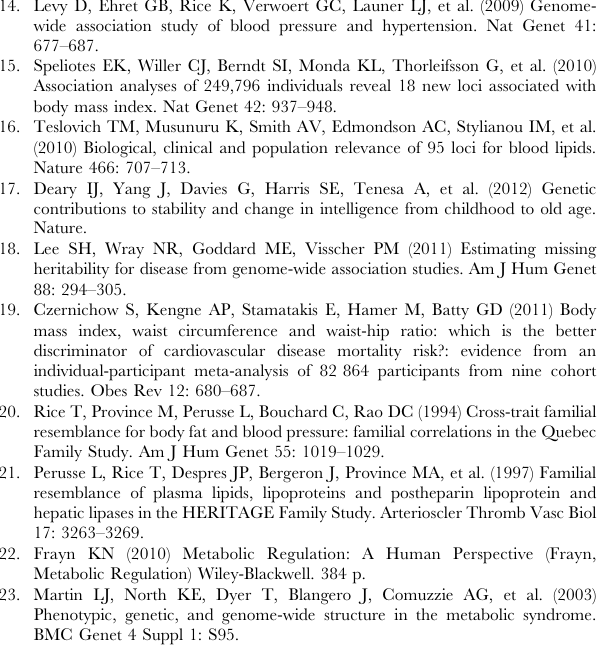
Figure S1 Height h g2 versus number of SNPs by sampling the allele frequency from 0.05 to 0.5 (red =low to high, blue =high to low, black = using all SNPs). A) h g2 estimates for height relative to the number of SNPs (mean and s.e.). B) Standard error versus number of SNPs. Figure S2 Genetic correlation coefficient for unrelated individ- uals versus the genetic correlation coefficients for related individuals. Shown are the mean and standard errors. Dashed line is the least squares fit with the y-intercept fixed at 0 estimated using a Monte Carlo method (slope= 0.44). Figure S3 A) Genetic correlation coefficients versus the phenotypic correlation coefficients for related individuals. Shown are the mean and standard errors. Dashed line is the least squares fit with the y-intercept fixed at 0 estimated using a Monte Carlo method (slope= 1.2). B) Genetic correlation coefficients versus the phenotype correlation coefficients for unrelated individuals. Shown are the mean and standard errors. Dashed line is the least squares fit with the y-intercept fixed at 0 estimated using a Monte Carlo method (slope= 0.85). Table S1 Atherosclerosis Risk in Communities Study (ARIC) population statistics by sex; mean (sd; minimum-maximum). BMI= body-mass index, WC = waist circumference, WHR= wa- ist-to-hip ratio, GLU =fasting glucose, INS= fasting insulin, TG = fasting triglycerides, HDL= fasting high-density lipoprotein, SBP= systolic blood pressure. Table S2 Framingham Heart Study (FHS) population statistics. Table S3 Genetic and residual covariance estimates for the ARIC population among related individuals. Mean and standard